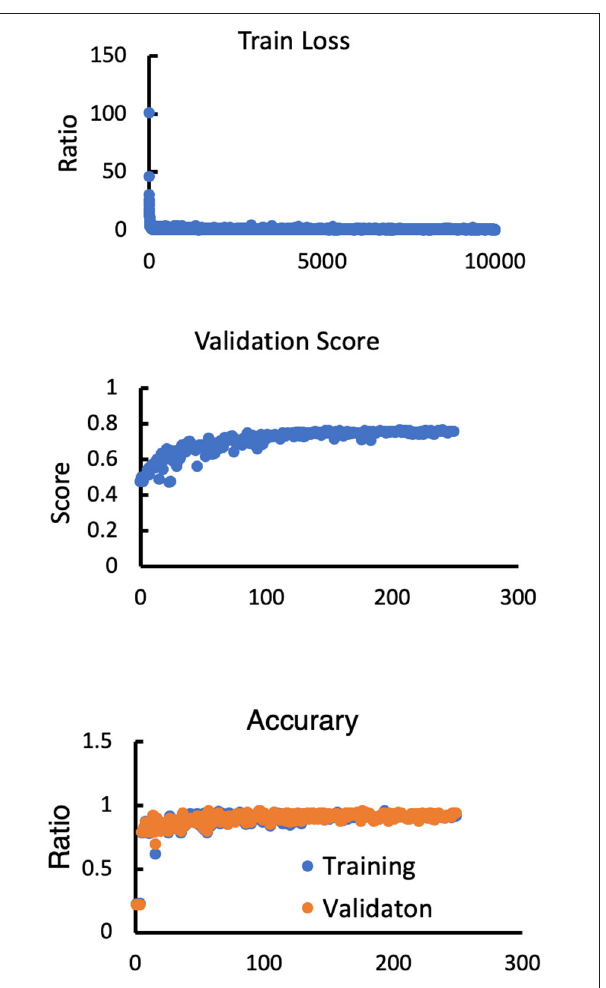
FIGURE 4 | Model performance in terms of the training loss, validation score, training accuracy and validation